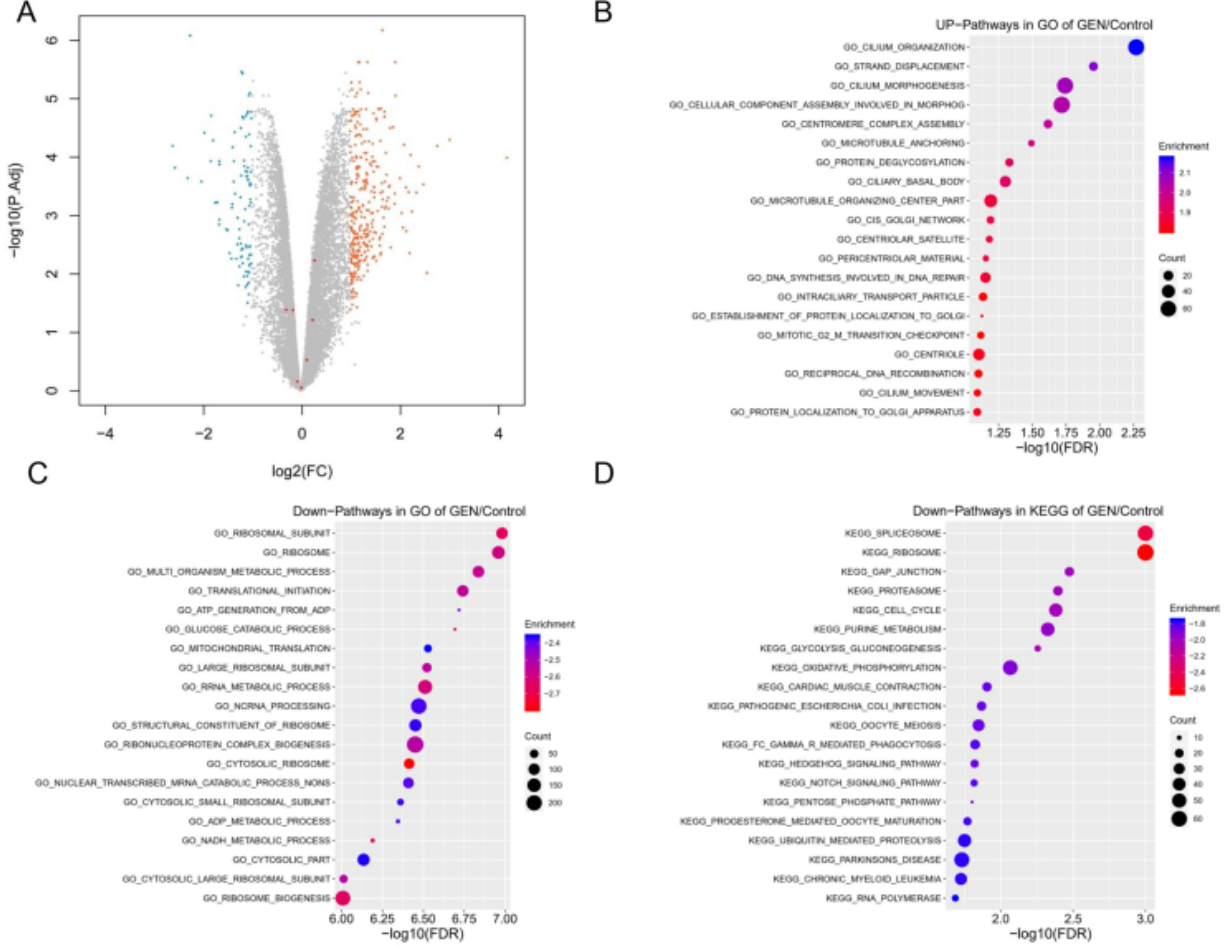
Figure 10. ( A ) Volcano plot of DEGs identified following genistein treatment (compared with control). Grey dots, genes with no significant difference in expression; blue dots, downregulated genes; and orange dots, upregulated genes. Fold-change was calculated using gene-normalized expression of the genistein group/gene-normalized expression of the control group. Differences in expression with a p value < 0.05 and a Log 2 (fold change) > 1 were considered statistically significant. ( B , C ) Gene ontology enrichment of up- and downregulated DEGs after genistein treatment. ( D ) KEGG enrichment of upregulated DEGs after genistein treatment.